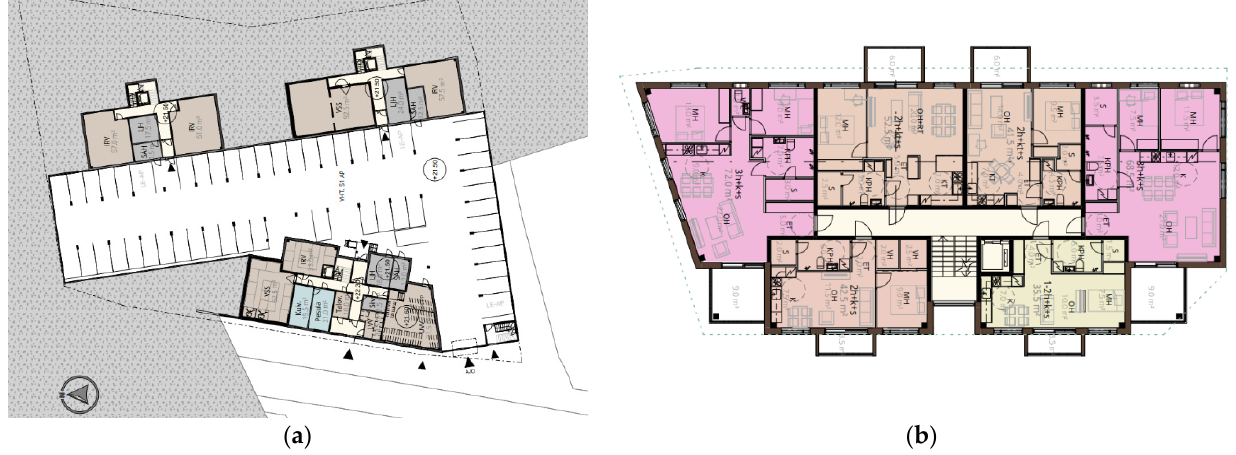
Figure 4. Architectural floor plans: ( a ) general site plan; ( b ) typical floor plan of the hybrid build- Figure 3. The designed five-story hybrid building in three dimensions (3D): ( a ) standalone view; ing.